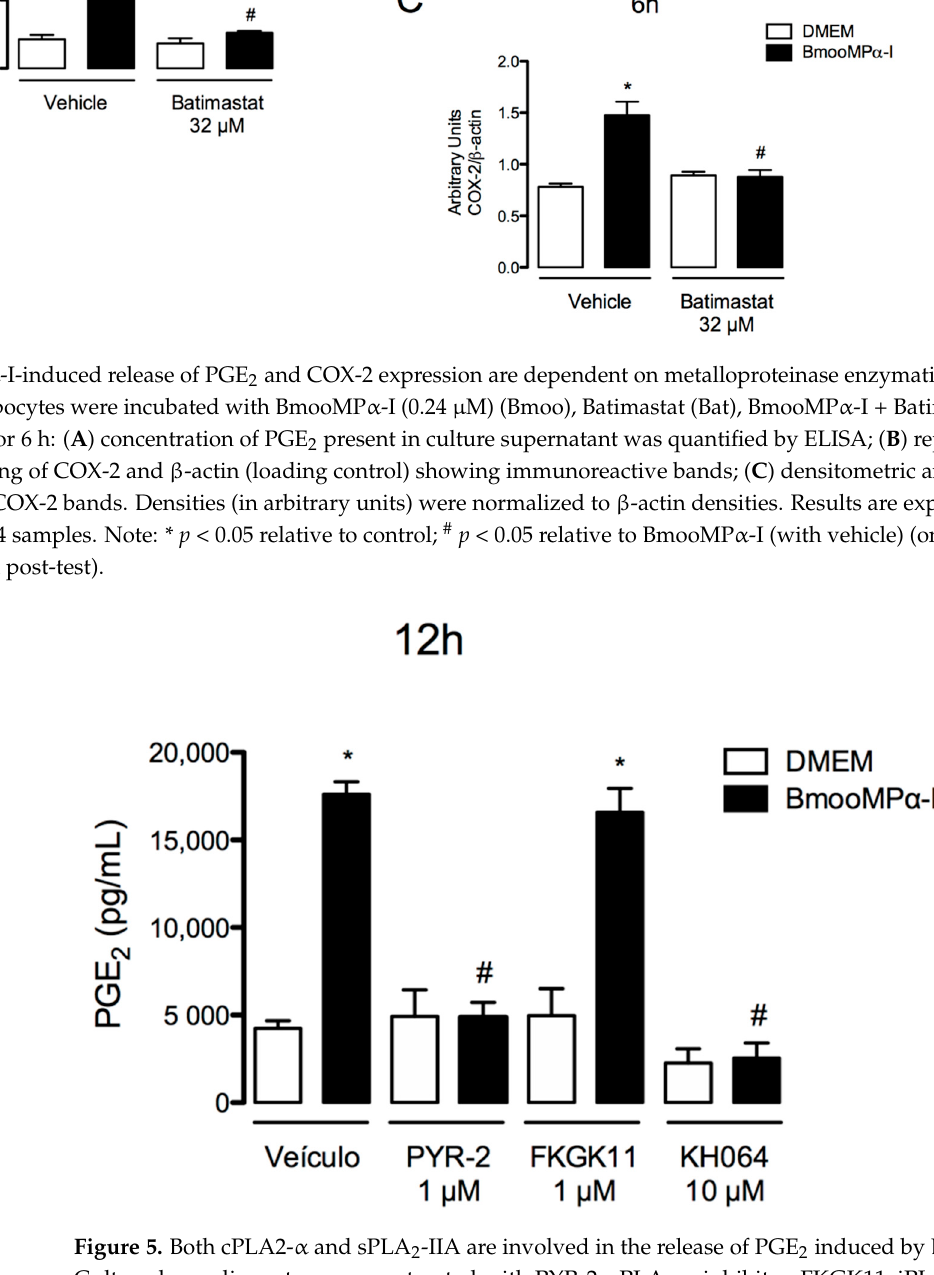
Figure 5. Both cPLA2- α and sPLA 2 -IIA are involved in the release of PGE 2 induced by BmooMP α